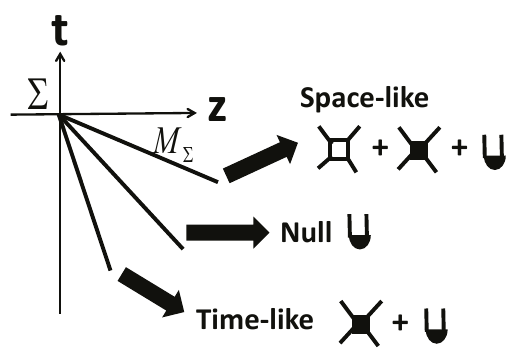
Figure 11 . The structures of quantum gates for each slice M (cid:6) in the Poincare AdS, where M (cid:6) is either space-like, null or time-like. The white square gate with four legs corresponds to a non- unitary (Euclidean) one, while the black one to a unitary (Lorentzian) one. The black semi circle gate with two legs describes a pair creation of EPR pair. The (cid:12)rst two quantum gates contribute to the left hand side of (4.13), while the (cid:12)nal one does